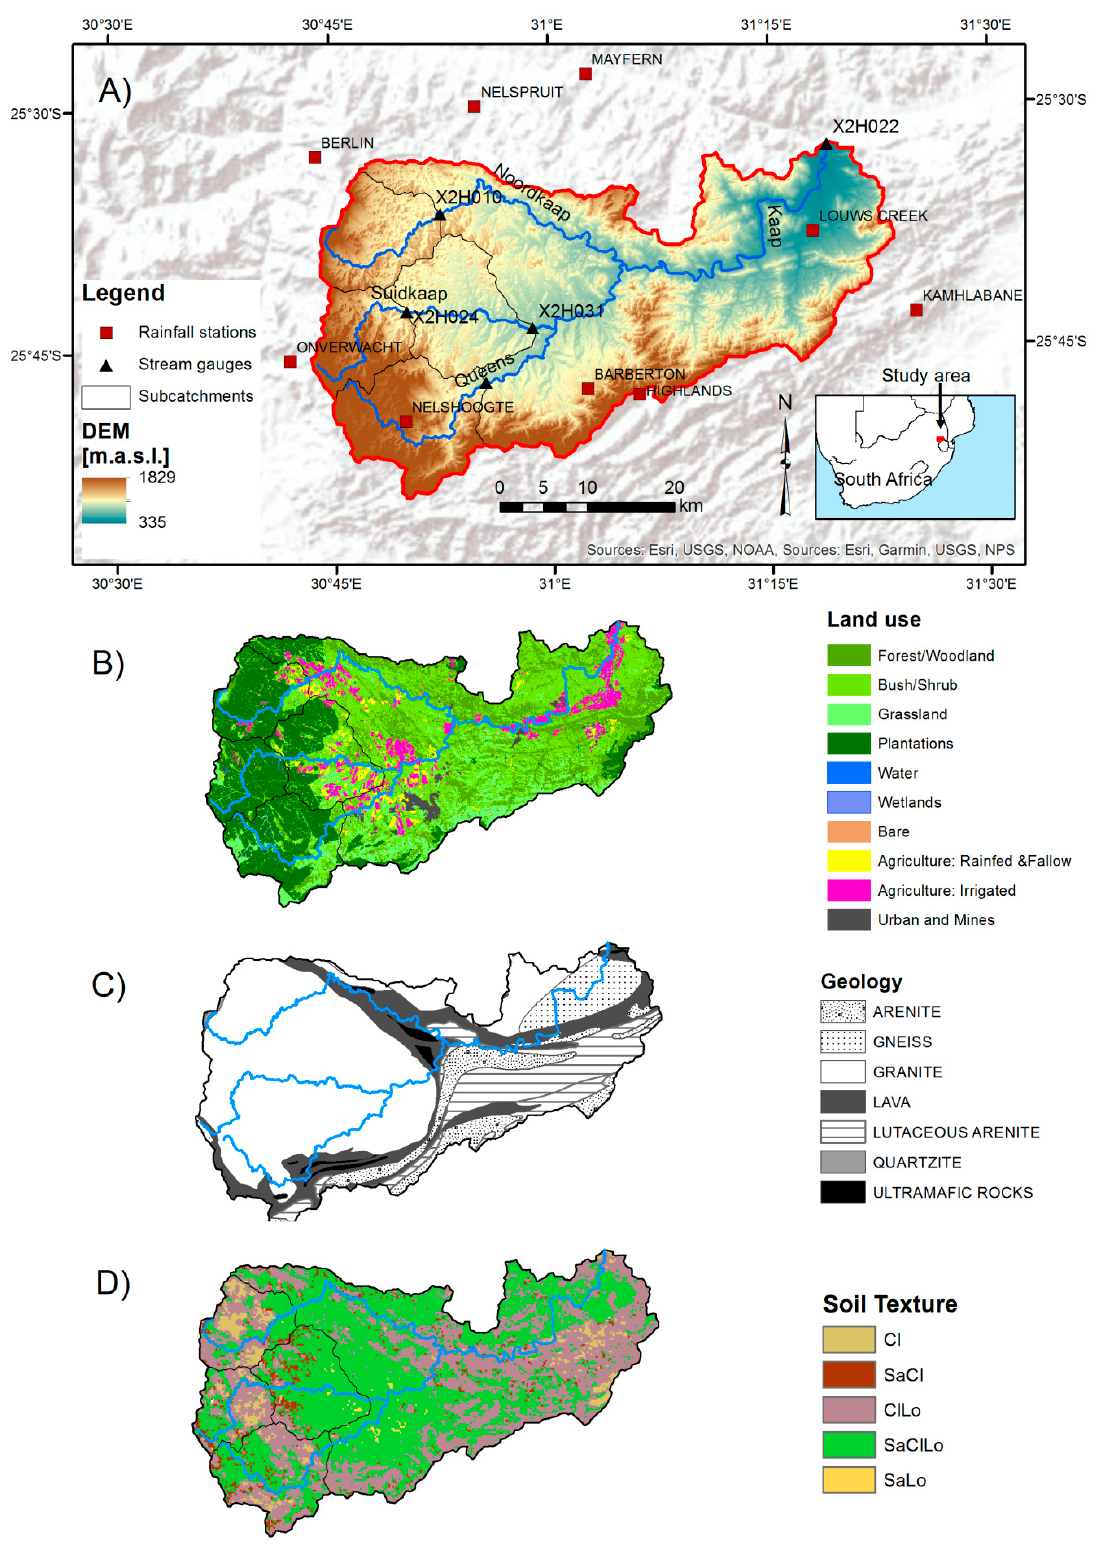
Figure 1. ( A ) Location of Kaap catchment in South Africa (inset) and DEM of Kaap catchment with stream gauges, rainfall stations and sub catchment delineation; ( B ) Land-use and land-cover map of Kaap catchment; ( C ) Geological map [26]; and ( D ) Soil texture based on Soil Grids 250 m dataset [22,23]; the predominantly occurring textures are: Clay (Cl), Sandy clay (SaCl), Clay loam (CL), Sandy clay loam (SaClLo) and Sandy loam (SaLo).